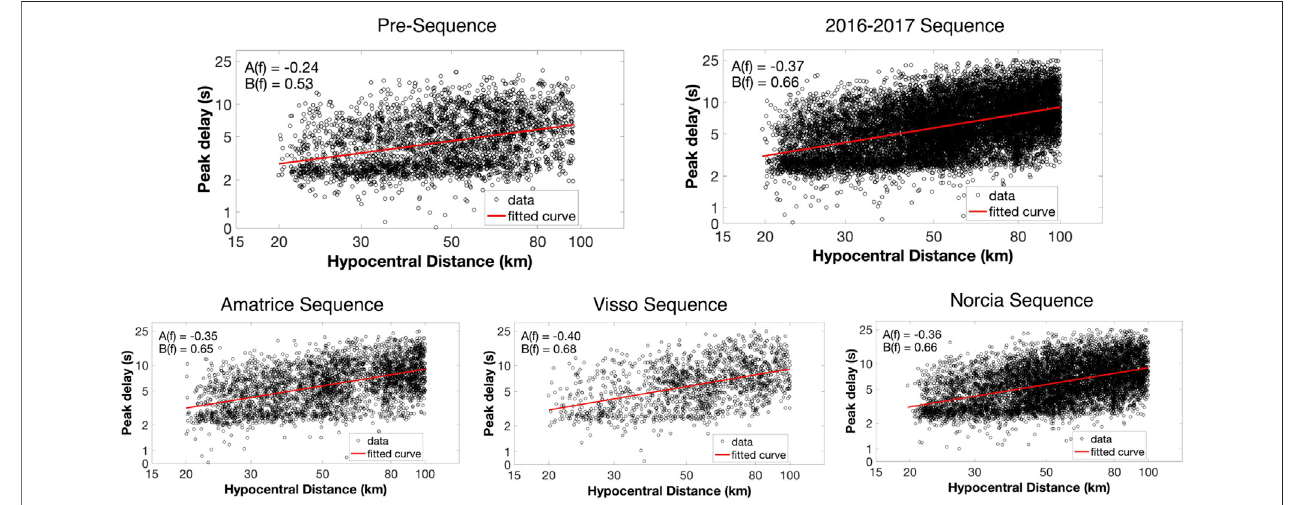
FIGURE 3 | Log – log plot of peak delay (s) as a function of the hypocentral distances (km) for the pre-sequence, 2016 – 2017 sequence, and single sequences at 1.5 Hz. The red solid line represents the best linear fi t for the peak delay measurement (black circles). A(f) and B(f) are the coef fi cients of the best linear fi t.